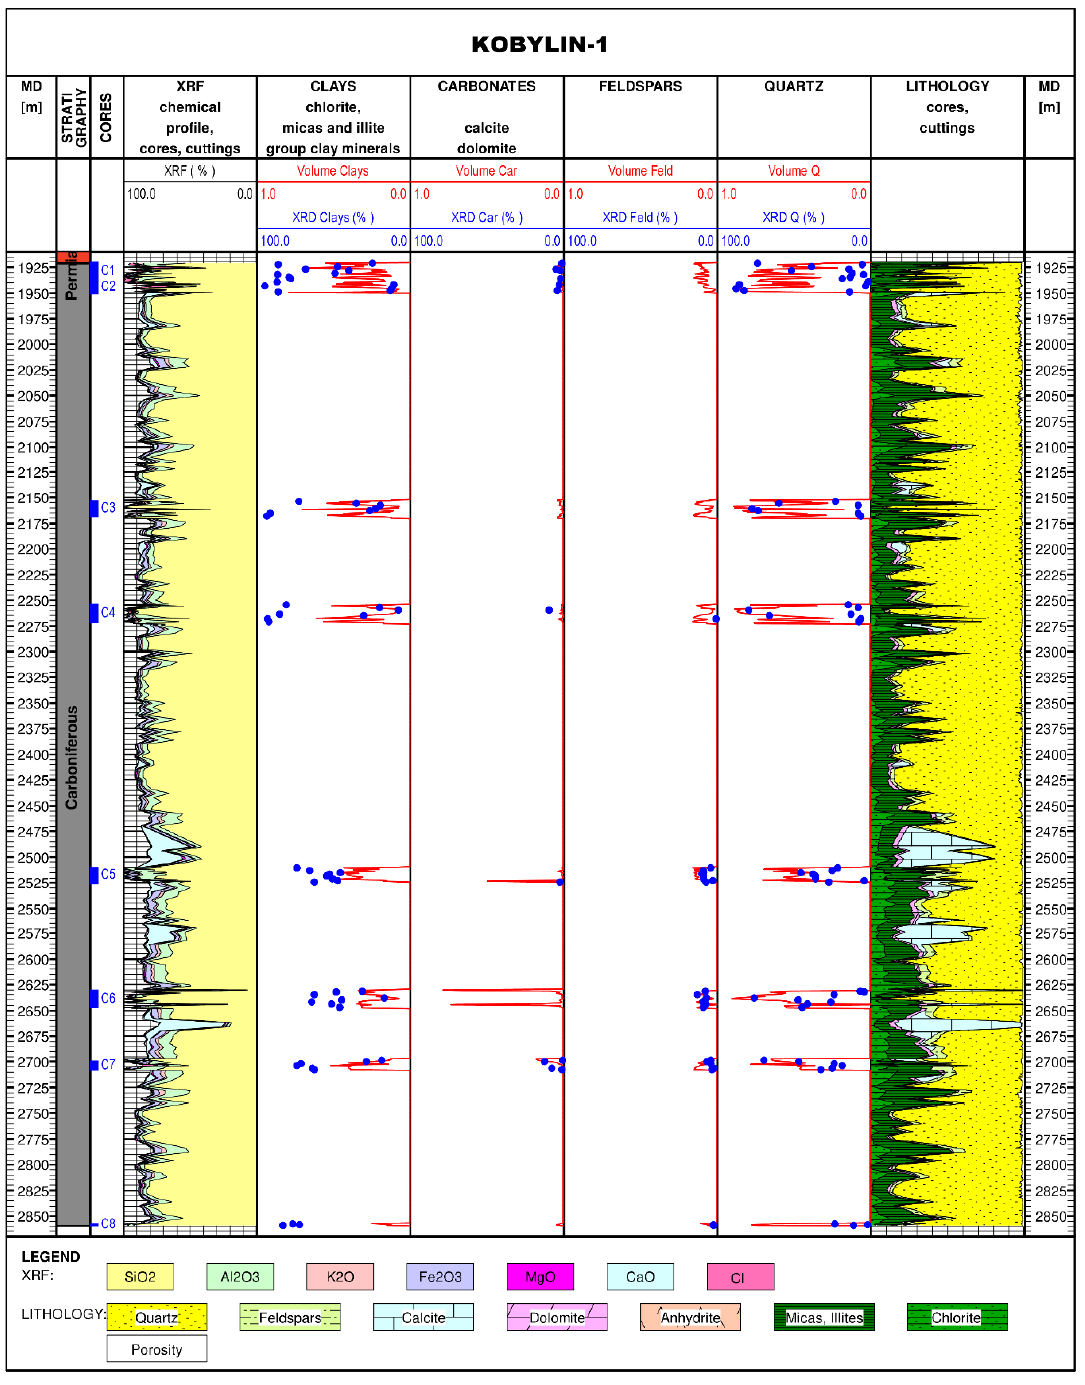
Figure 14. The result of lithological profile reconstruction based on chemical composition Figure14. Theresultoflithologicalprofilereconstructionbasedonchemicalcompositionmeasurementstaken measurements taken on core samples and drill cuttings in the Kobylin-1 borehole with XRD mineral on core samples and drill cuttings in the Kobylin-1 borehole with XRD mineral composition measurements.